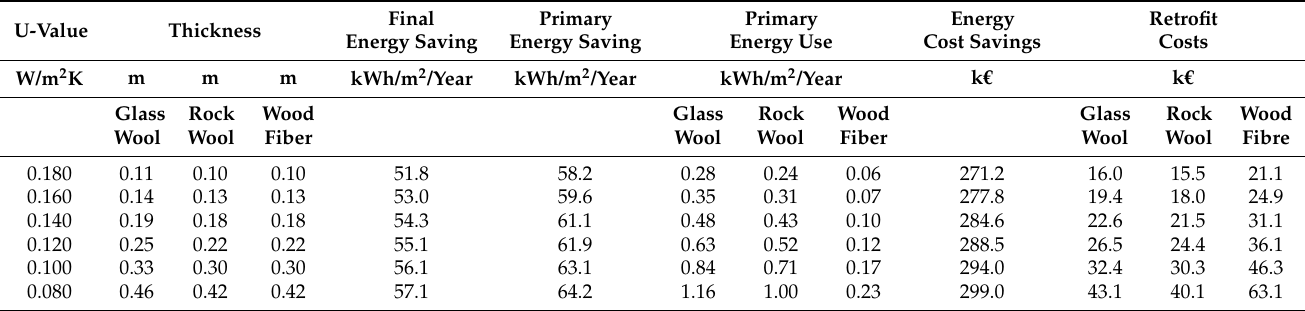
Table 3. Thicknesses, final and primary energy savings, energy cost savings, and retrofit costs of extra insulation of different materials on external walls with equally improved U-value.